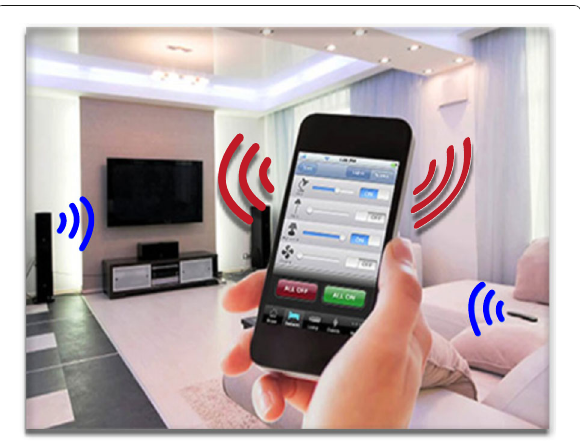
Fig. 12 BackCom application: smart